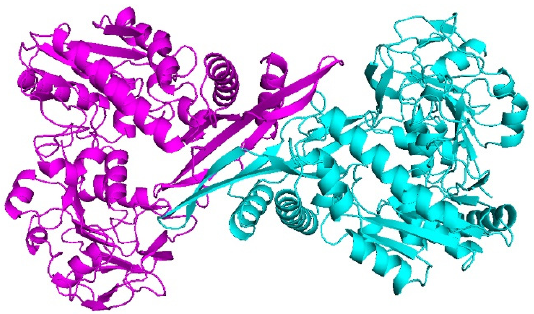
Figure 1. Molecular structure of C Las GMPS.